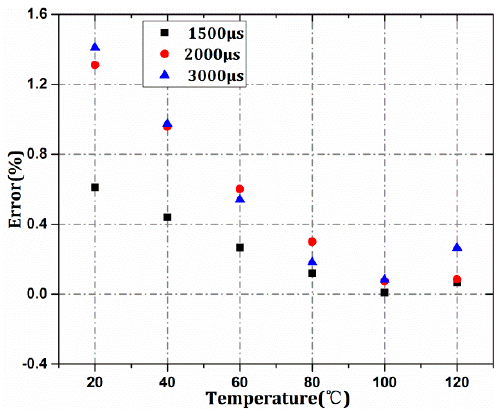
Figure 4. Errors of high-speed calibration considering the integration time.